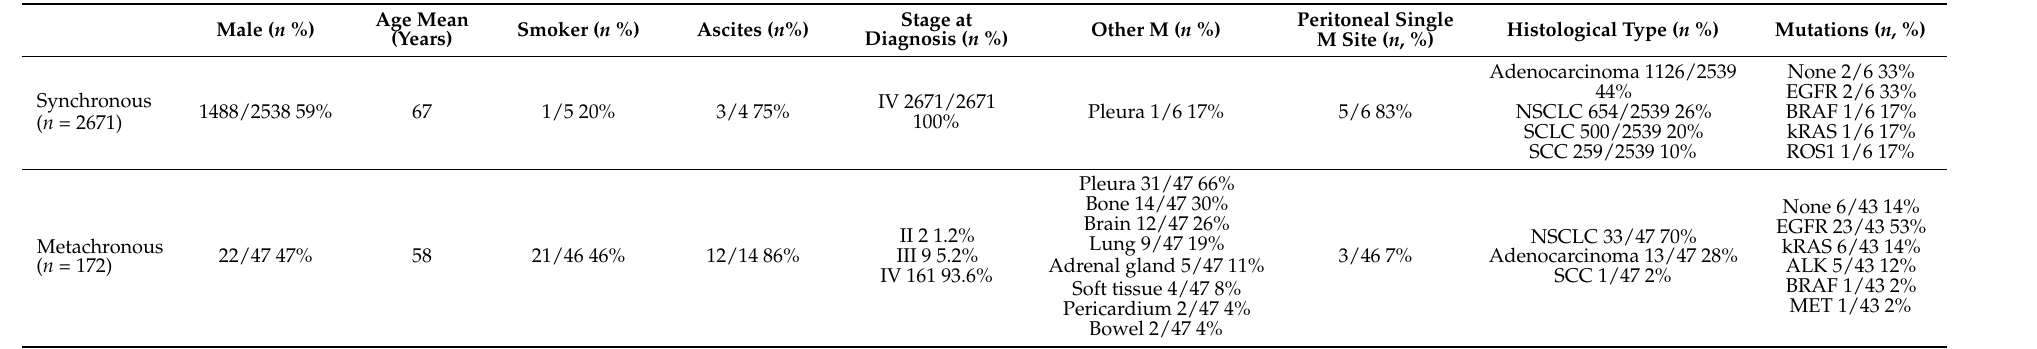
Table 4. Synchronous and metachronous PCLC patient